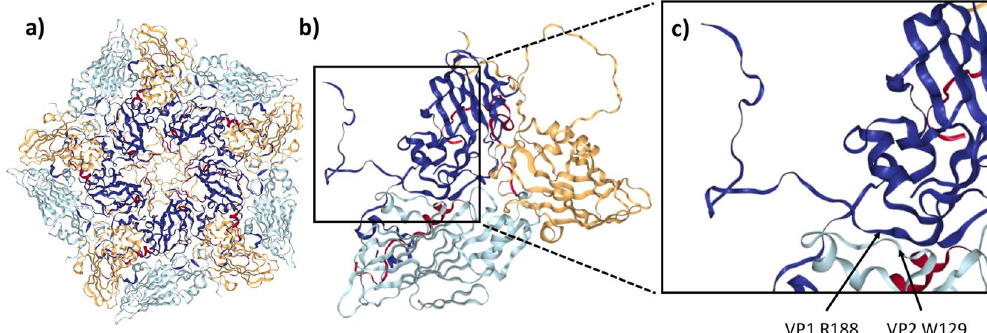
Figure 4. Location of residues VP1 R188 (within the conserved motif) and VP2 W129 in the virus structure. ( a ) The structure of a pentamer from within the FMDV A22 Iraq capsid is shown (from PDB 4GH4 21 ). ( b ) An expanded view of a single protomer viewed (from a different angle) is shown and the box marks a further expanded view, as shown in ( c ) with the residues VP1 R188 and VP2 W129 at the interface between VP1 and VP2 indicated. VP1 is shown in dark blue and VP2 is in light